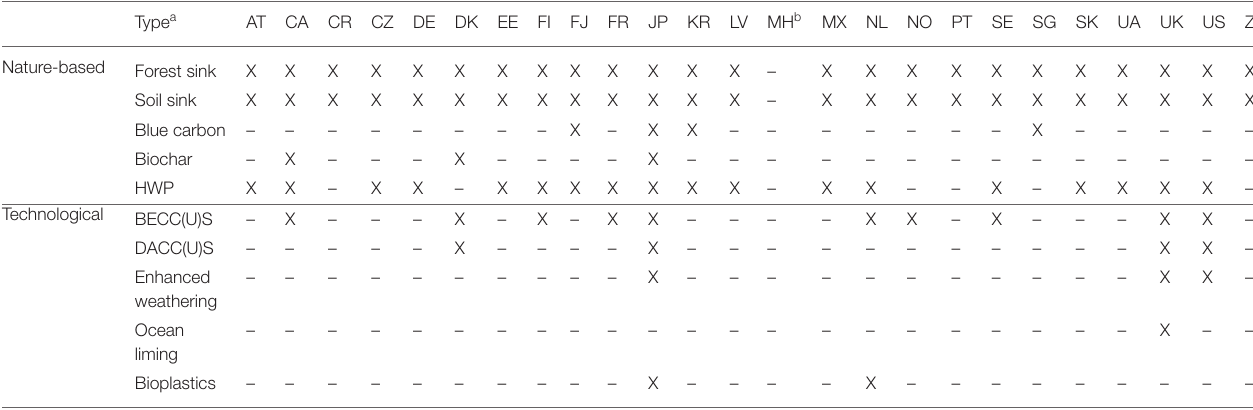
TABLE 4 | References to carbon dioxide removal (CDR) methods in long-term climate strategies by country (reference to CDR is marked by an x; absence of CDR is marked by a